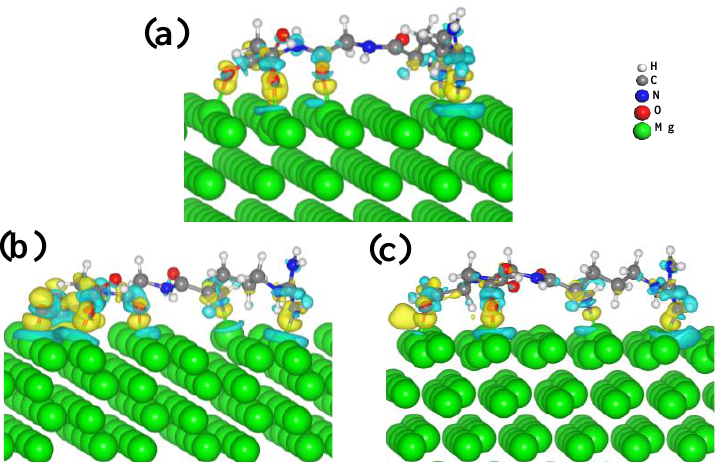
Figure 9. Charge density difference of RGD on the ( a ) Mg(0001), ( b ) Mg (11 2 0) and ( c ) Mg (10 1 1) surfaces. The values of the isosurfaces are ±0.03 e/Å 3 , and the yellow and light cyan isosurfaces indicate the accumulation and depletion of charge density.